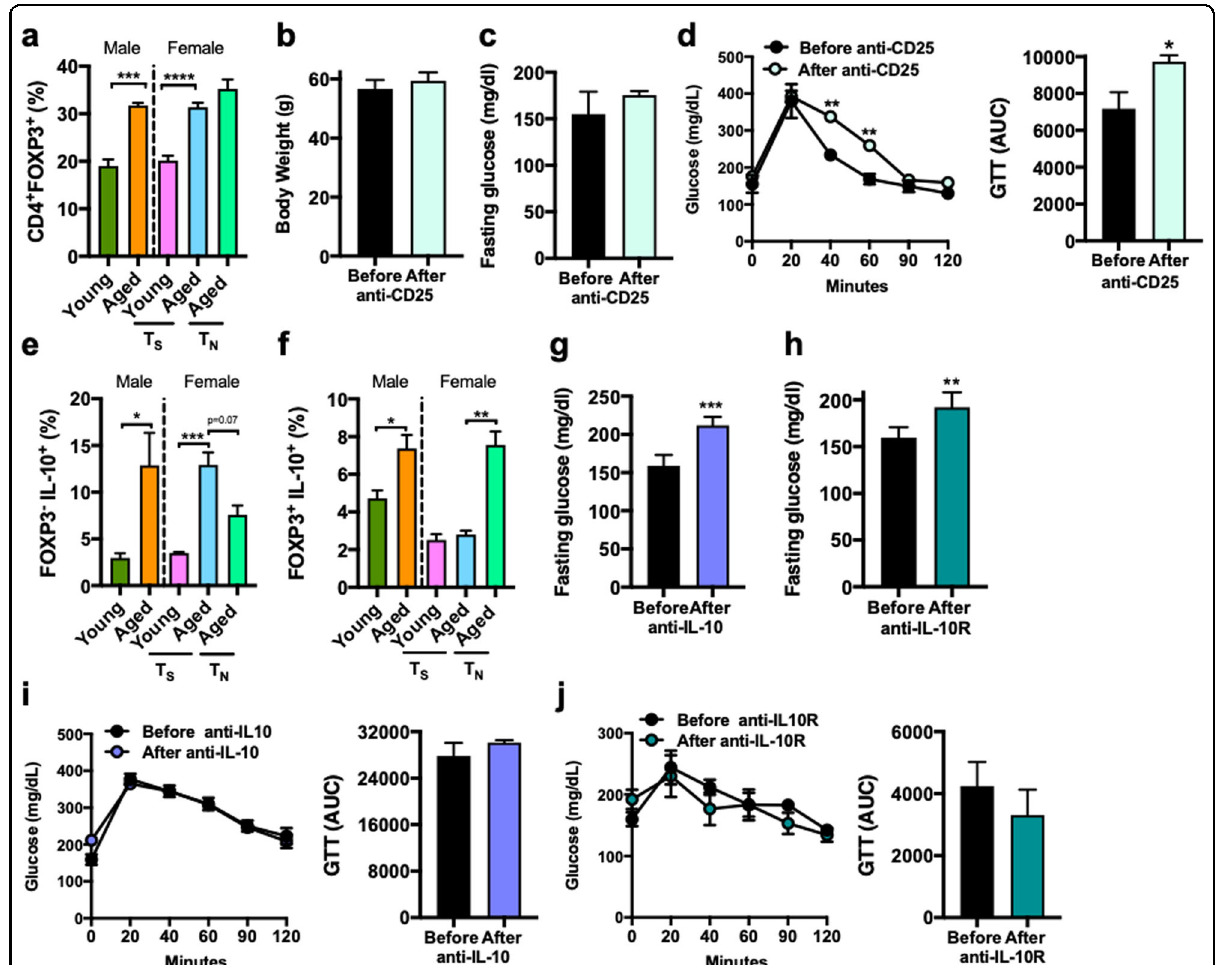
Fig. 5 Aging promotes accumulation of T reg , Tr1-like cells and IL-10 production that may contribute to aging-associated mitigation of metabolic derangement severity. a 2-month-old (Young) and 14-month-old (Aged) male and female C57BL/6 mice, ( n = 4 – 5/condition) were housed at 22 °C (T S ) or 30 °C (T N ) and fed Chow or HFD for up to 20 weeks. Flow cytometry quanti fi cation of splenic T reg (CD3 + CD4 + FOXP3 + ). b – d Aged male mice ( n = 3 – 4/group) were housed at 22 °C (T S ) and fed HFD for 20 weeks. b Body weight at time of harvest. c At week 18, mice were treated, twice weekly, for 2 weeks, with anti-CD25 (100 μ g/mice) neutralizing Ab. Fasting glucose levels before and after treatment. d Left, glucose tolerance test (GTT) and Right, GTT area under the curve (AUC) before and after anti-CD25 treatment. e , f 2-month-old (Young) and 14-month-old (Aged) male and female C57BL/6 mice, ( n = 4 – 5/condition) were housed at 22 °C (T S ) or 30 °C (T N ) and fed Chow or HFD for up to 20 weeks. e Flow cytometry quanti fi cation of splenic Tr1-like cells (CD3 + CD4 + FOXP3 - IL-10 + ) post PMA/Ionomycin (50 ng/ml and 1 mg/ml respectively). f Flow cytometry quanti fi cation of splenic IL-10 producing T reg (CD3 + CD4 + FOXP3 + ) post PMA/Ionomycin (50 ng/ml and 1 mg/ml respectively). g – j Aged mice ( n = 4 – 7/group) were housed at 22 °C (T S ) and fed HFD for 20 weeks. At week 18, mice were treated, twice weekly, for 2 weeks, with anti-IL-10 (100 μ g/mice) neutralizing Ab or with anti-IL-10R (500 μ g/mice) neutralizing Ab. g Fasting glucose levels before and after anti-IL-10 treatment. h Fasting glucose levels before and after anti-IL-10R treatment. i Left, glucose tolerance test (GTT) and Right, GTT area under the curve (AUC) before and after anti-IL-10 treatment. j Left, glucose tolerance test (GTT) and Right, GTT area under the curve (AUC) before and after anti-IL-10R treatment. A single experiment. Data represent means + SE. a, d , e One-way ANOVA * P < 0.05, ** P < 0.005 and *** P < 0.0005. b , c , f – i Unpaired Student t test * P < 0.05, ** P < 0.005 and *** P <